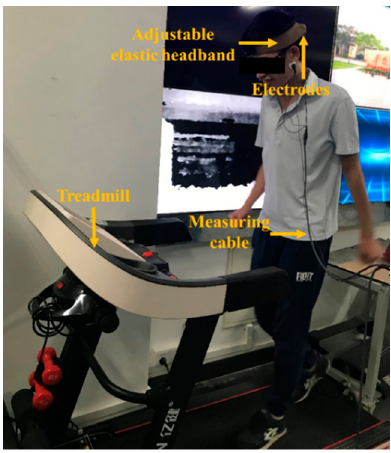
Figure 6. Dynamic electroencephalogram (EEG) measurement experiment setting.